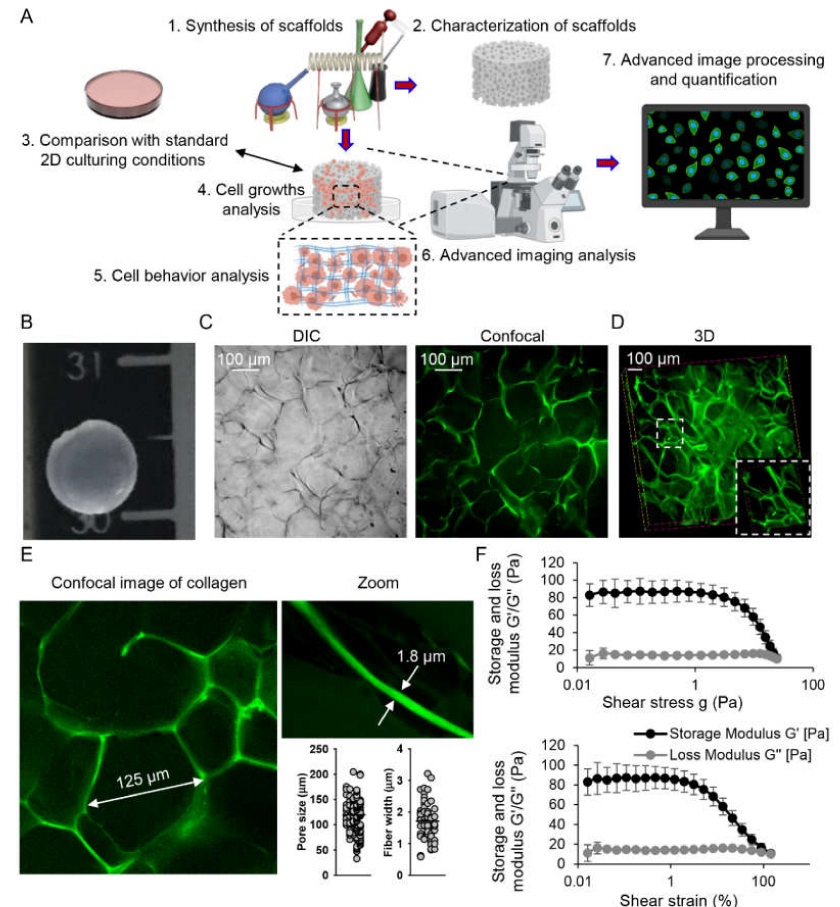
Figure 1. Synthesis and characterization of porous collagen sca ff olds. ( A ) The schematic concept of the study. ( B ) A prepared 3D collagen sca ff old representative image. ( C ) Representative images of a collagen sca ff old captured by di ff erential interference contrast (DIC) and confocal microscopy. ( D ) Three-dimensional reconstruction of a collagen sca ff old morphology as captured by confocal microscopy. Three-dimensional reconstruction was done using ImageJ software (NIH). Insert shows zoomed region of the collagen sca ff old. ( E ) High-resolution fluorescence confocal imaging of the collagen sca ff old with subsequent quantitative assessments of pore size ( n = 183) and fiber width ( n = 57). Quantitative assessments were done using ImageJ software (NIH). ( F ) Viscoelastic properties of collagen sca ff olds as determined by plate–plate crosshatched geometry in oscillatory strain sweep mode with frequency 1 Hz. Figure 1A was created using BioRender.com